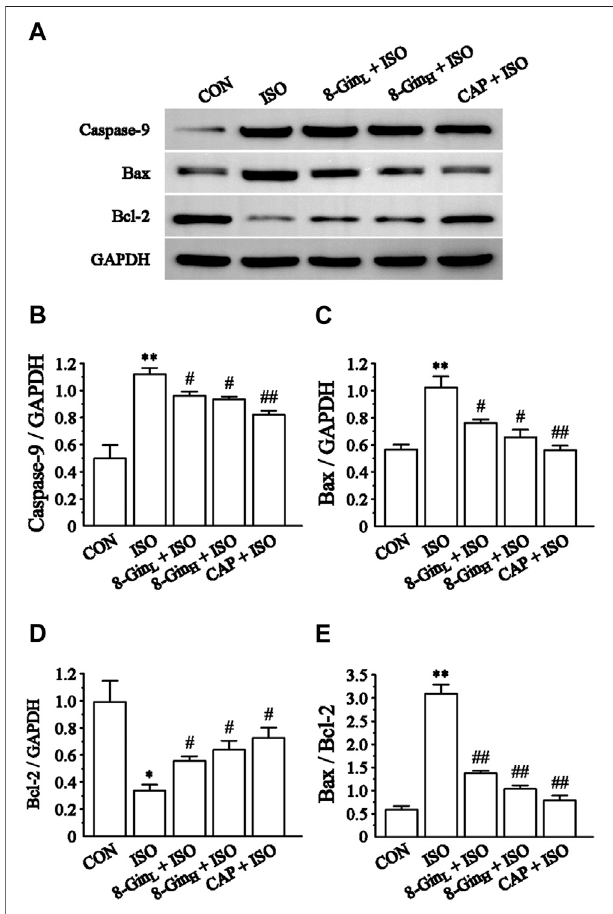
FIGURE9| Effects of8-Gin onthe expression ofCaspase-9, Bax,Bcl-2 protein. (A) Representative images of Caspase-9, Bax, Bcl-2 protein expression that were exhibited from cardiac tissue in the CON, ISO, 8-Gin L + ISO, 8-Gin H + ISO, and CAP + ISO groups. (B – D) Pooled analysis of Caspase-9, Bax, Bcl-2 protein expression by western blot analysis on which intensity was normalized to GAPDH. (E) The ratio of Bax and Bcl-2 protein expression by western blot analysis. Data are shown as the mean ± SEM, n (cid:1) 3. * p < 0.05, ** p < 0.01 vs. the CON group; # p < 0.05, ## p < 0.01 vs. the ISO